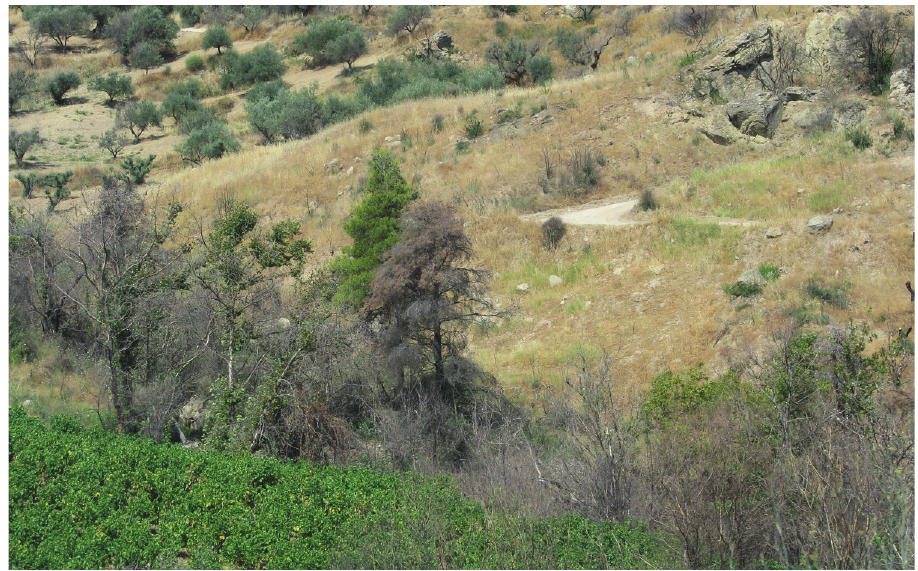
Figure 24. Habitat of P. admetus . Greece, Peloponnesse Peninsula, Mt. Chelmos, near Kalavrita, 800 m, 16 july 2008. Photo by V.A. Lukhtanov.